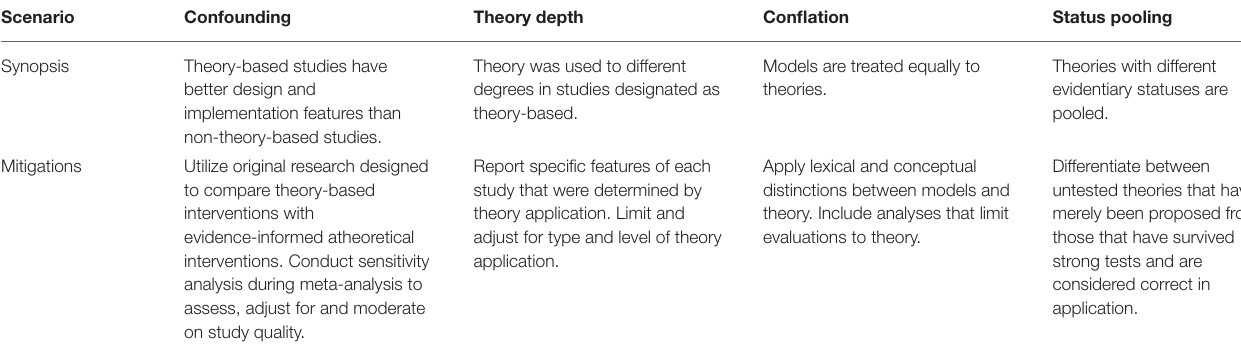
TABLE 2 | Challenges and mitigations in the evaluation of